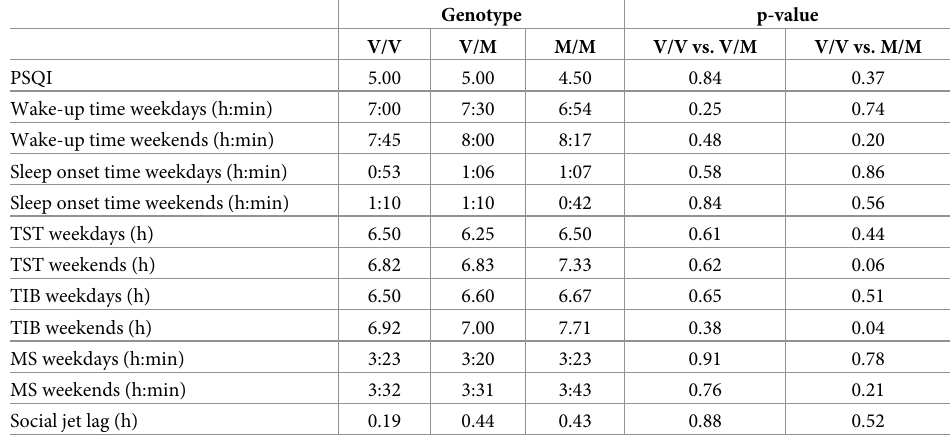
Analyses showed a significant difference in TIB on weekends between Val/Val and Met/Met. V/V: Val/Val, V/M: Val/Met, M/M: Met/Met, PSQI: the Pittsburgh Sleep Quality Index, TST: total sleep time, TIB: time in bed, MS: mid- sleep time.